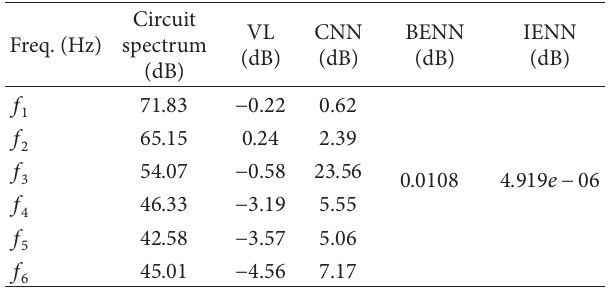
Figure 6: Comparison among four behavioral models in frequency domain with two-tone signal input. Table 2: Spectrum of the circuit and spectrum error of four behav- ioral models with two-tone signal